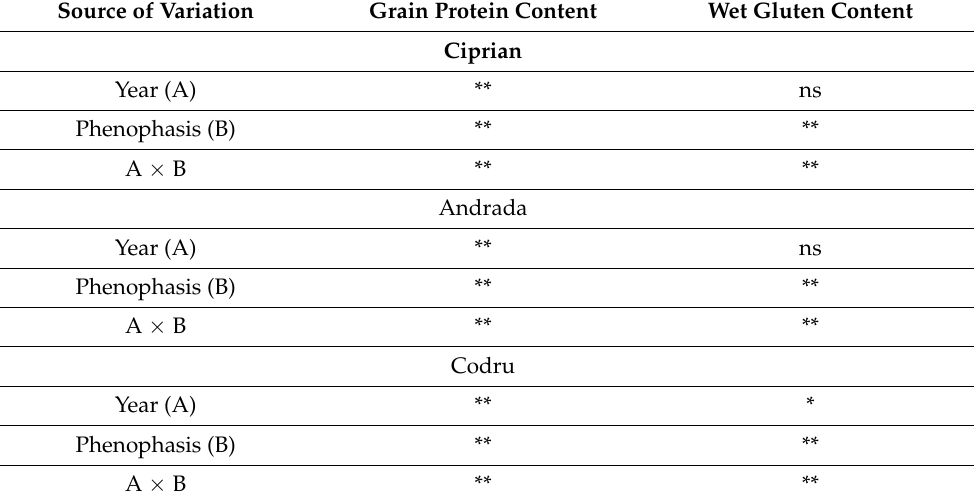
Table 2. ANOVA for grain-quality indices. Source of